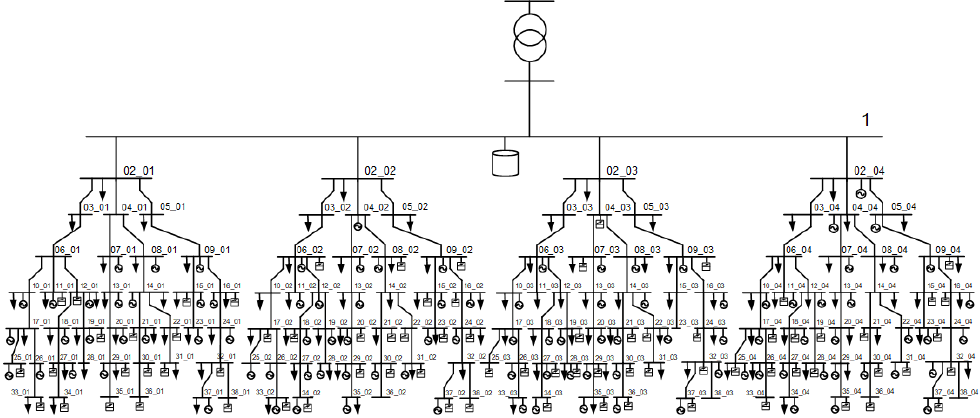
Figure A2. Cluster 02. Single-line diagram for the large network scenario.